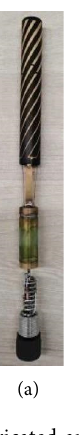
Figure 5: Photograph of the fabricated antenna: (a) front view and (b) upward view.